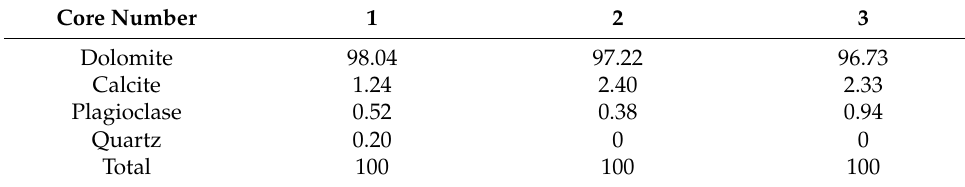
Table 2. Core components.